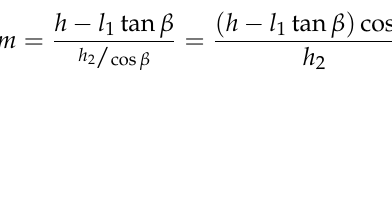
Figure 3. Side view of medicine storage tank.